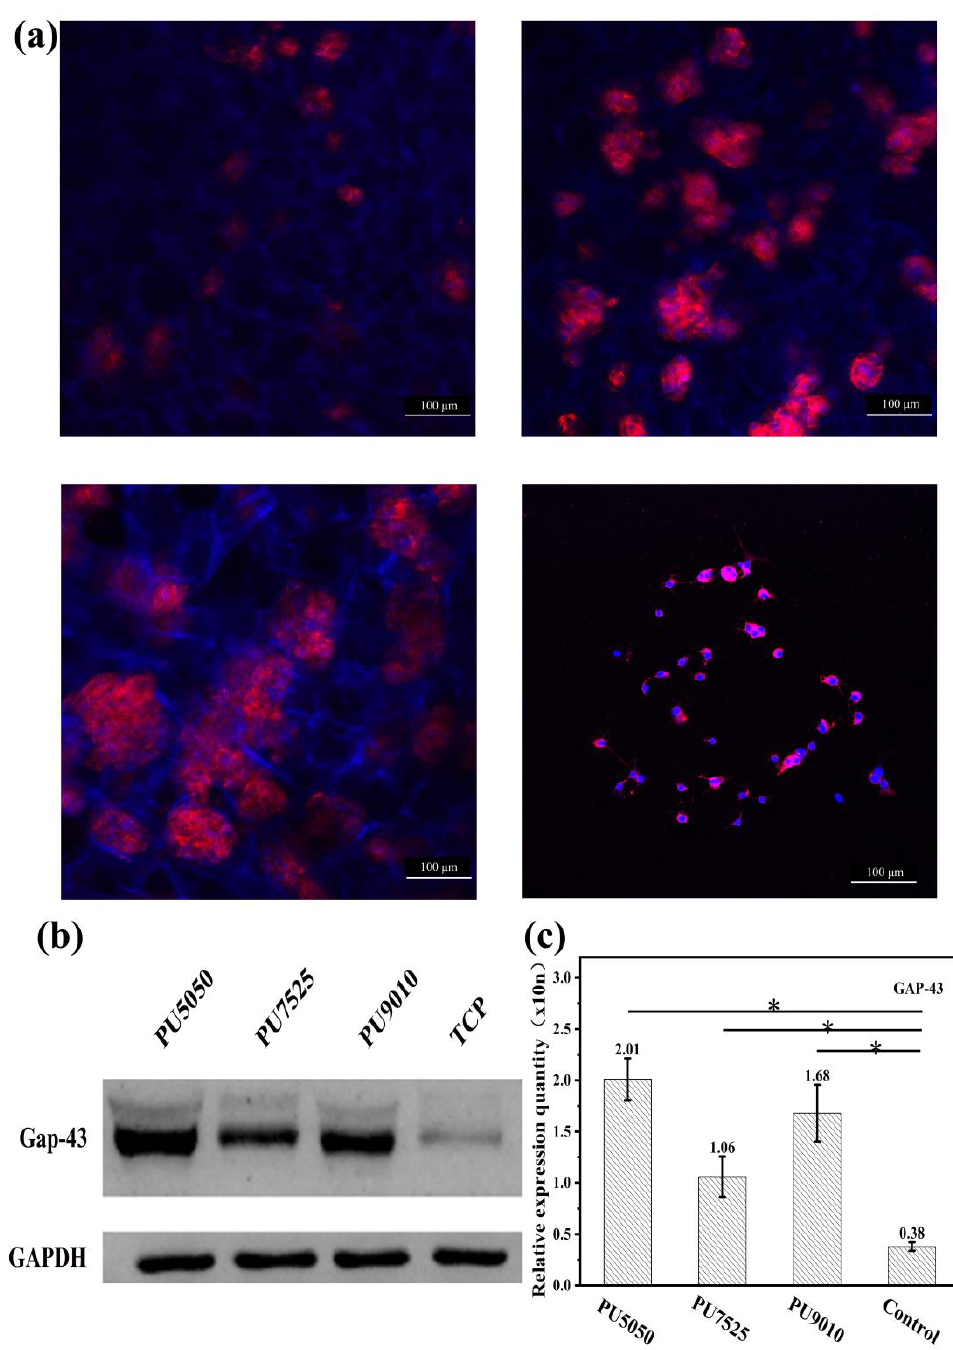
Figure 4. ( a ) PC12 cell morphology on PU5050, PU7525 and PU9010 scaffolds and TCP. Nuclei of cells were stained with Dapi (blue) (because of the absorbency of the scaffolds, their frames also appear blue); F-actin of cells was stained with rhodamine phalloidin (red). ( b ) The Gap-43 protein expressed by PC12 cells on scaffolds and control sample (TCP). ( c ) The relative Gap-43 protein content. The data are shown as mean ± SD (n ≥ 3). * p < 0.05 compared with TCP.